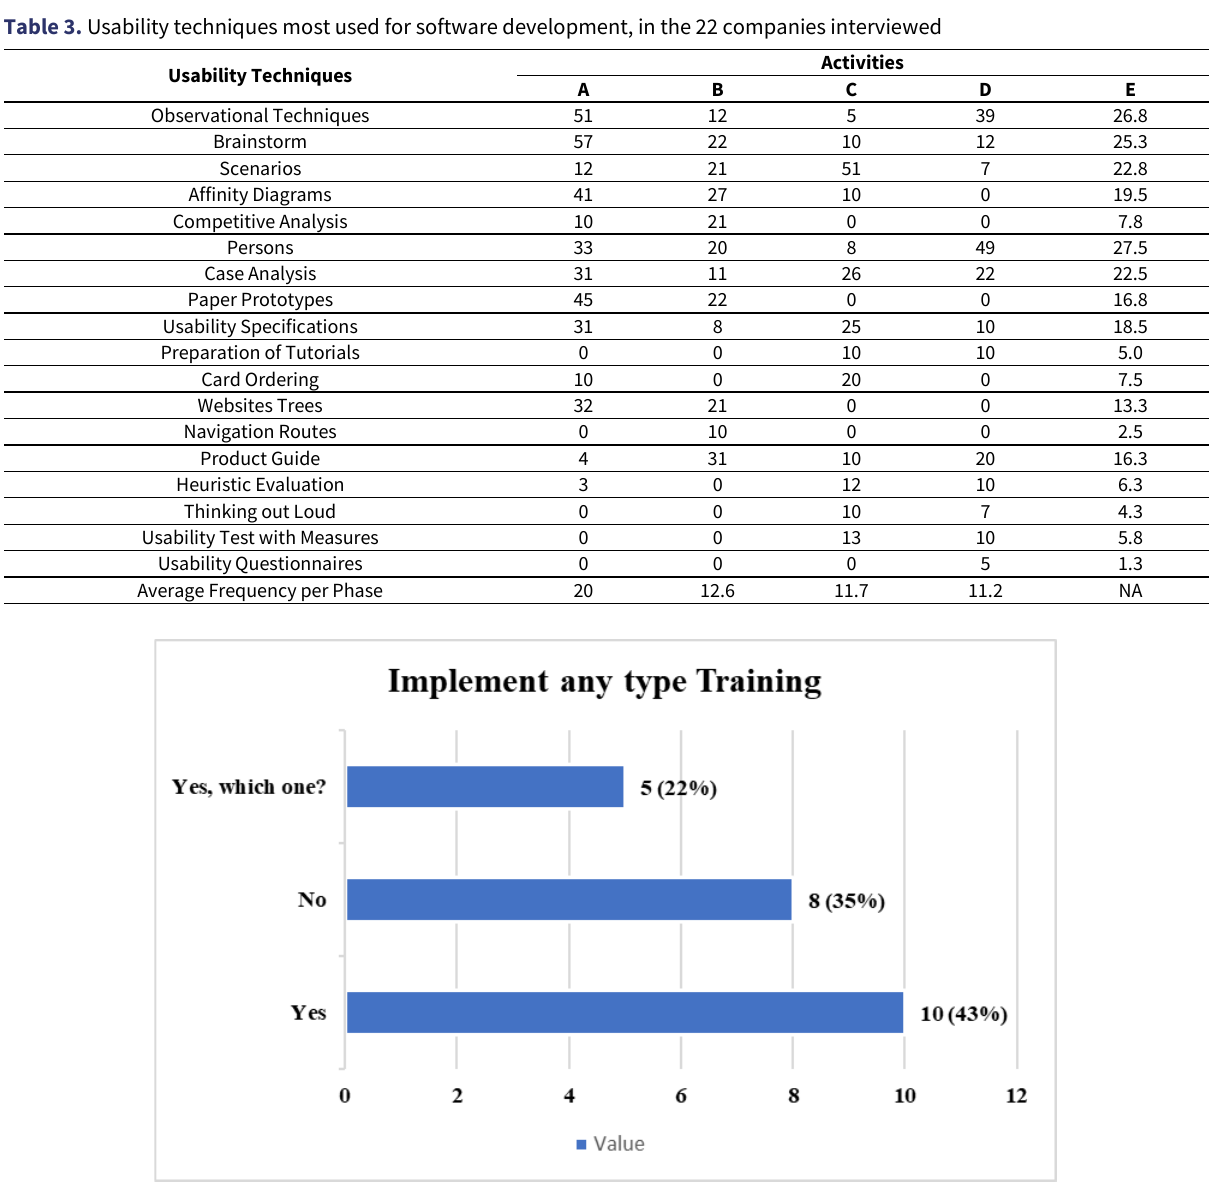
Figure 6. Type of training received by the development team regarding the agile methods